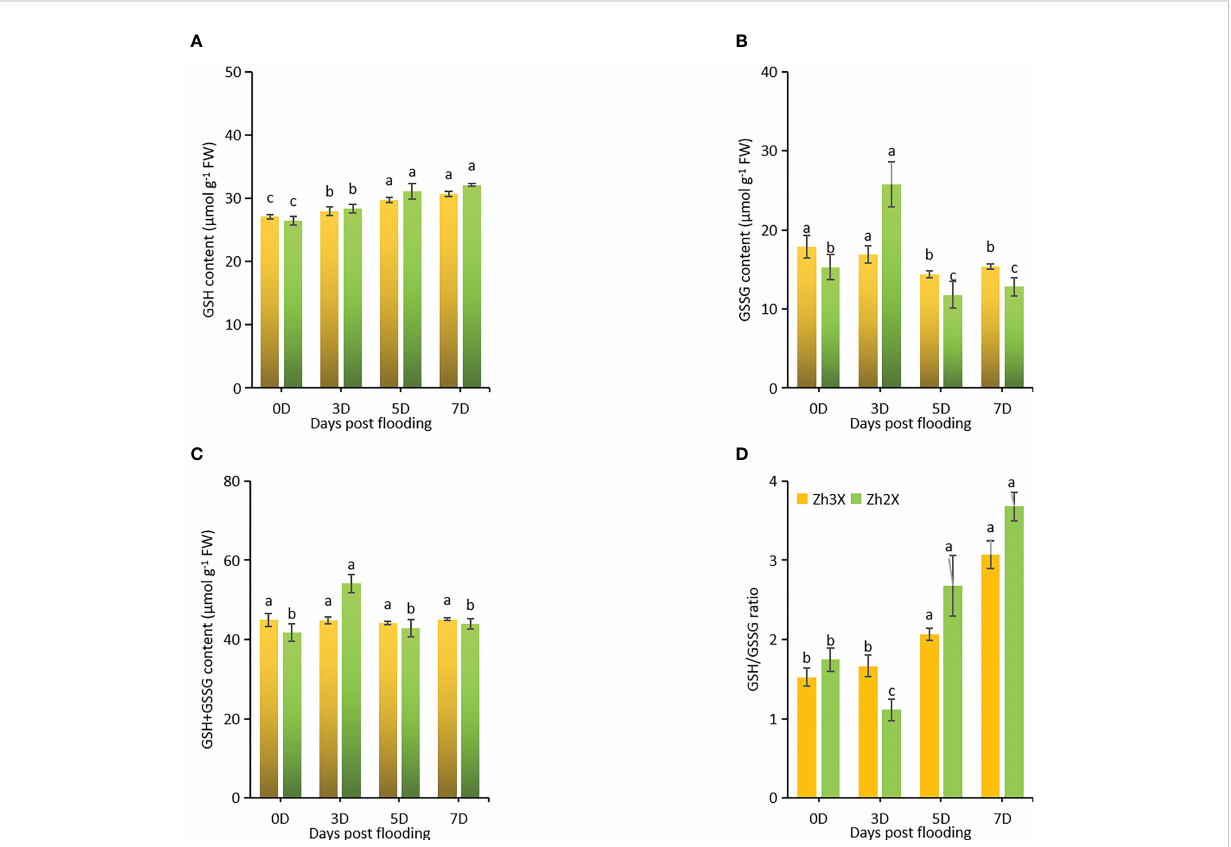
FIGURE 5 Fluctuations in the activities of ROS scavengers. (A) GSH, (B) GSSG, (C) GSH+GSSG, and (D) GSH/GSSG ratio. Perpendicular bars display averages ± SD (n = 6). Lower case letters above each bar present signi fi cant changes at p < 0.05 (Duncan ’ s multiple range